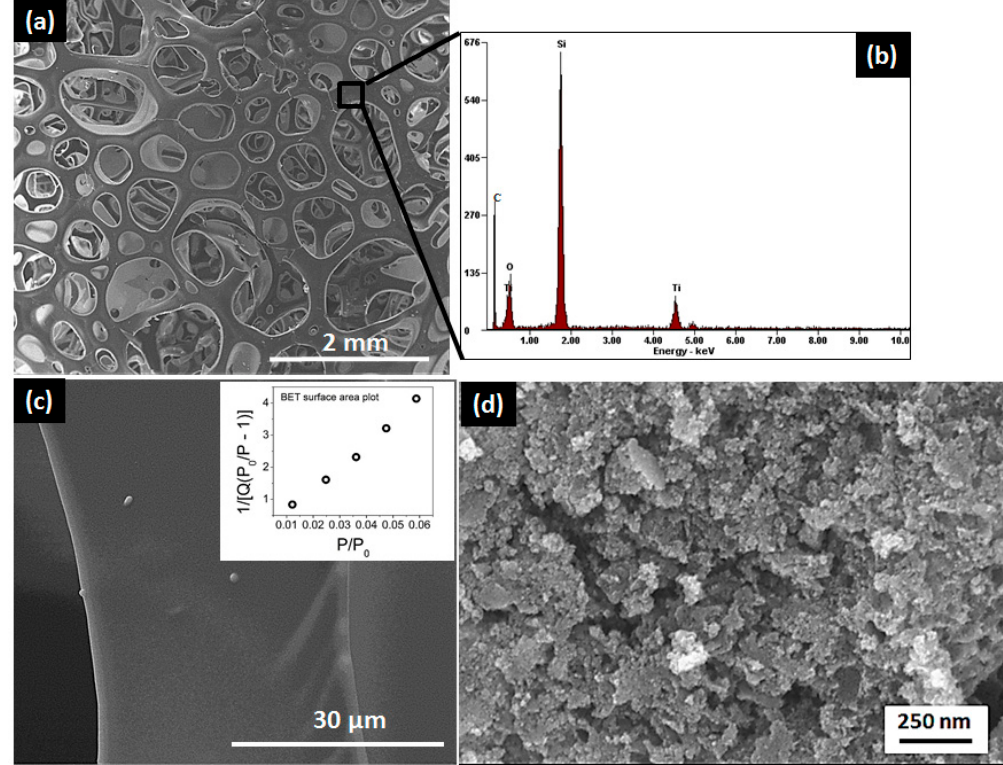
Figure 5. ( a ) SEM micrograph revealing the foamy nature of the macroporous sample; ( b ) corresponding EDS analysis; ( c ) Higher magnification micrograph, inset: BET surface area plot; ( d